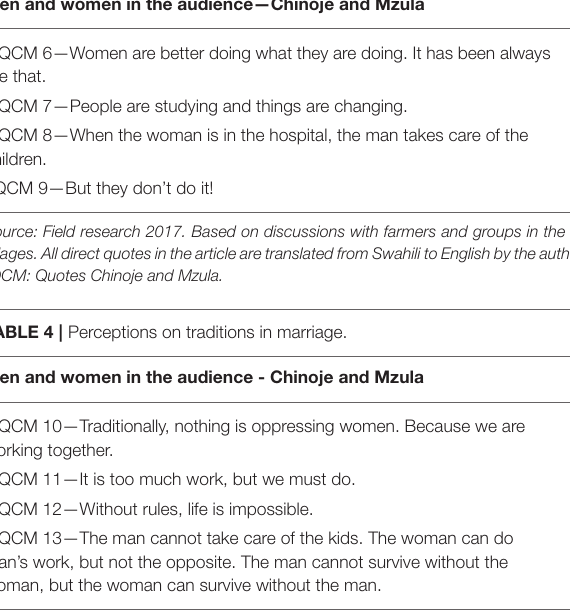
TABLE 3 | Perceptions on fixed gender roles.